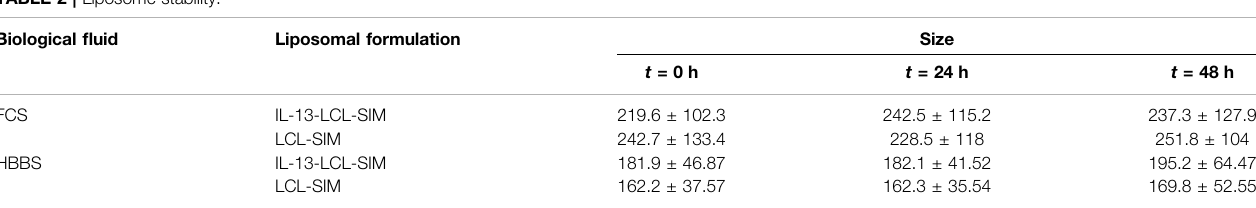
TABLE 2 | Liposome